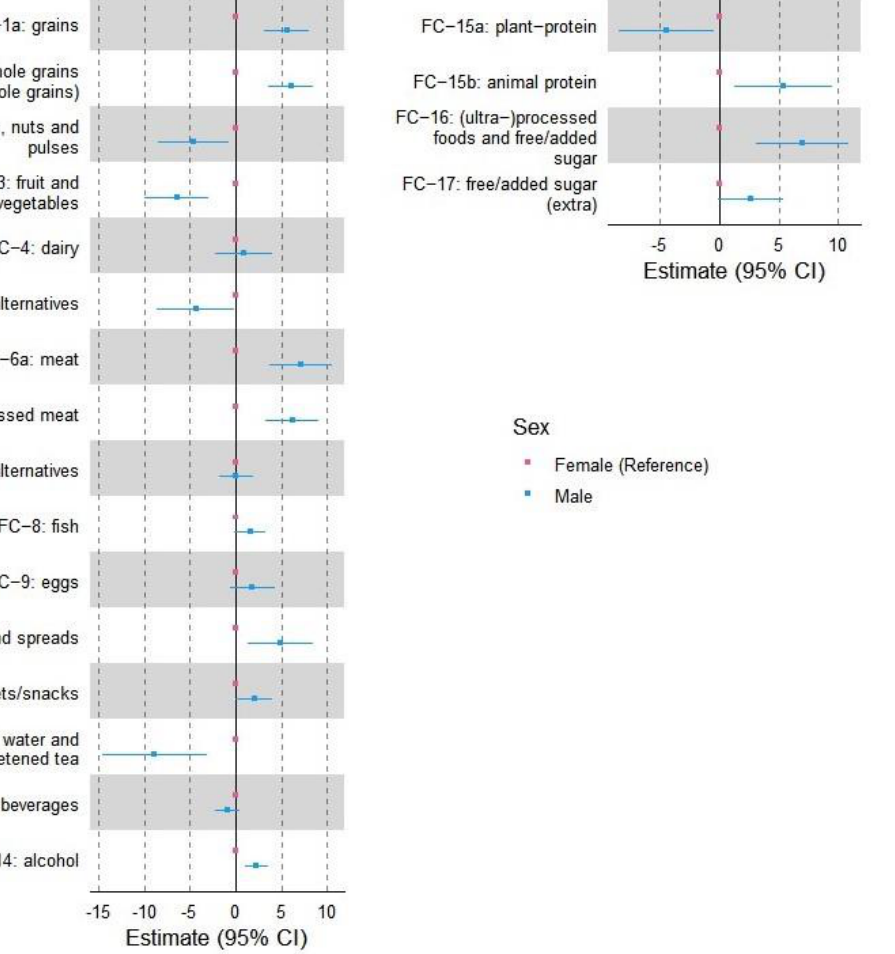
Figure 2. Forest plots with 95% confidence interval to display sex-based differences in basic (the left column) and umbrella (the right column) food clusters. Females are considered the reference, and the differences are shown based on the variations of males from females. FC — food clusters.